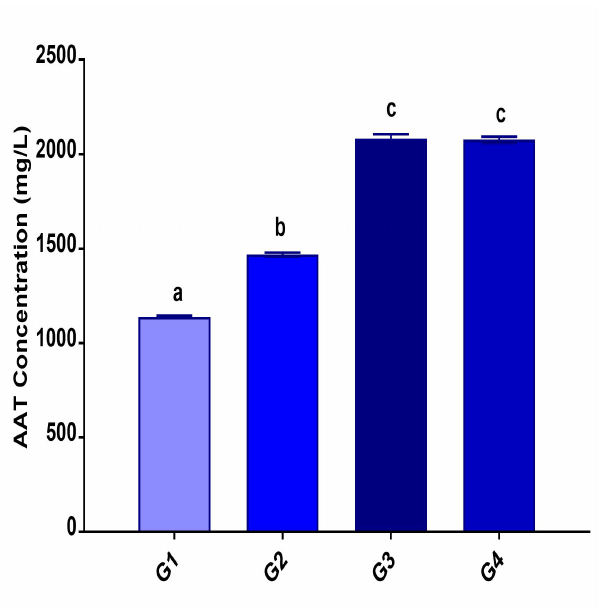
Figure 3. Comparison AAT concentrations in all studied groups. Each value represents the mean ± SEM.